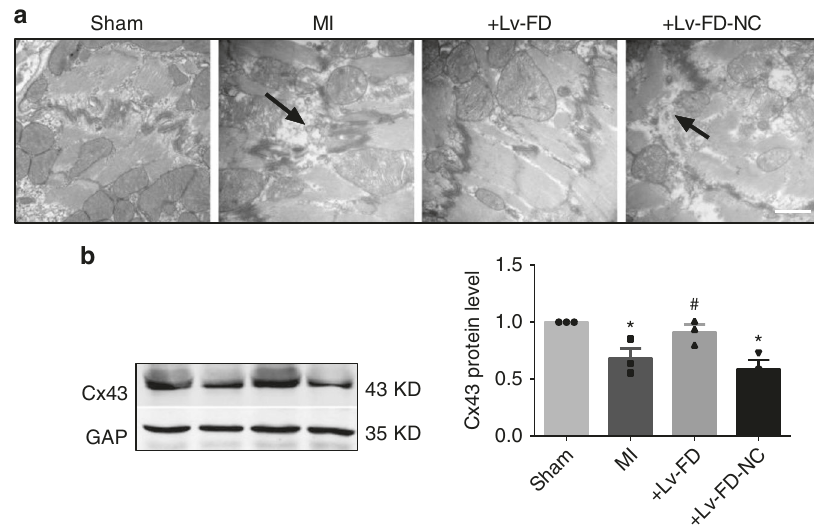
Fig. 8 Effect of FD on gap junctional integrity. a Typical examples of electron microscopic images (30,000× magni fi cation) showing the deranged intercalated discs in MI mice, and the effects of FD overexpression by Lv-FD on the microstructure of left ventricular cardiac muscles. Marked disruption of intercalated discs and gap junction was consistently observed in infarcted myocardium (dark arrows), and such derangement was ameliorated and restored to normal conditions after pretreatment with Lv-FD, but not with Lv-FD-NC. Similar observations were repeated in another three MI mice. b Effect of FD overexpression on the protein level of connexin43 (Cx43) in MI mice. Left panel: an example of Western blot bands; right panel: averaged data on Cx43 protein level. Cx43 expression was signi fi cantly repressed by MI and rescued by Lv-FD, relative to control and Lv-FD-NC. * P < 0.05 MI or Lv-FC-NC vs. Sham; # P < 0.05 Lv-FD vs. MI; n = 6 mice for each group. (Mean ± SEM; ANOVA followed by Dunnett ’ s test for multiple group comparisons, Student t